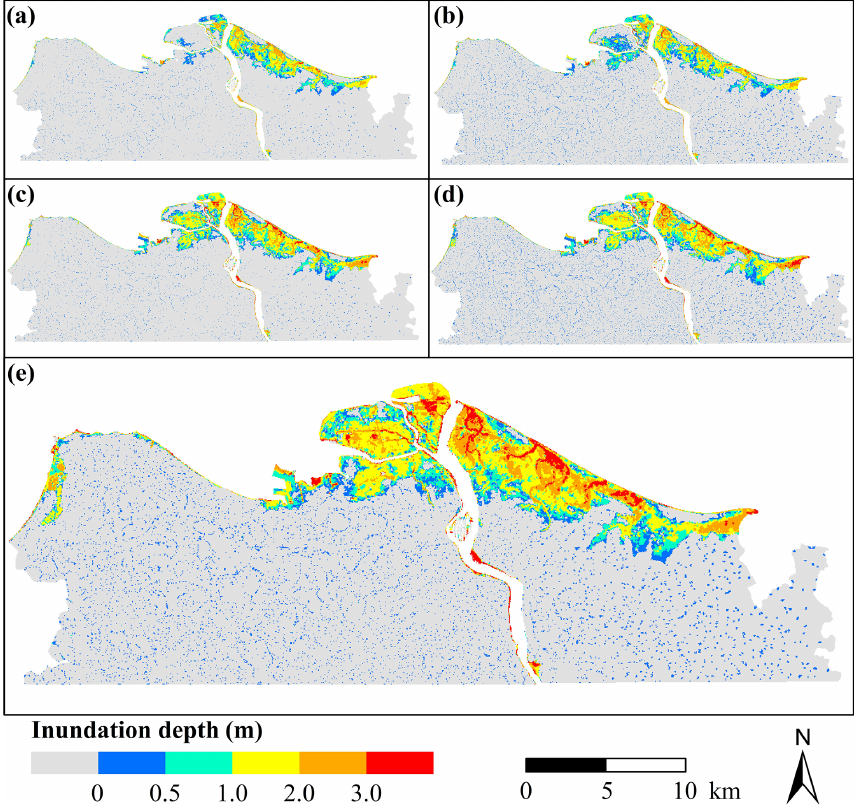
Figure 6. The compound flood inundation maps under different return period: (a) 5-year event, (b) 10-year event, (c) 25-year event, (d) 50- year event, and (e) 100-year event. Table 3. Inundation depth and area under different return